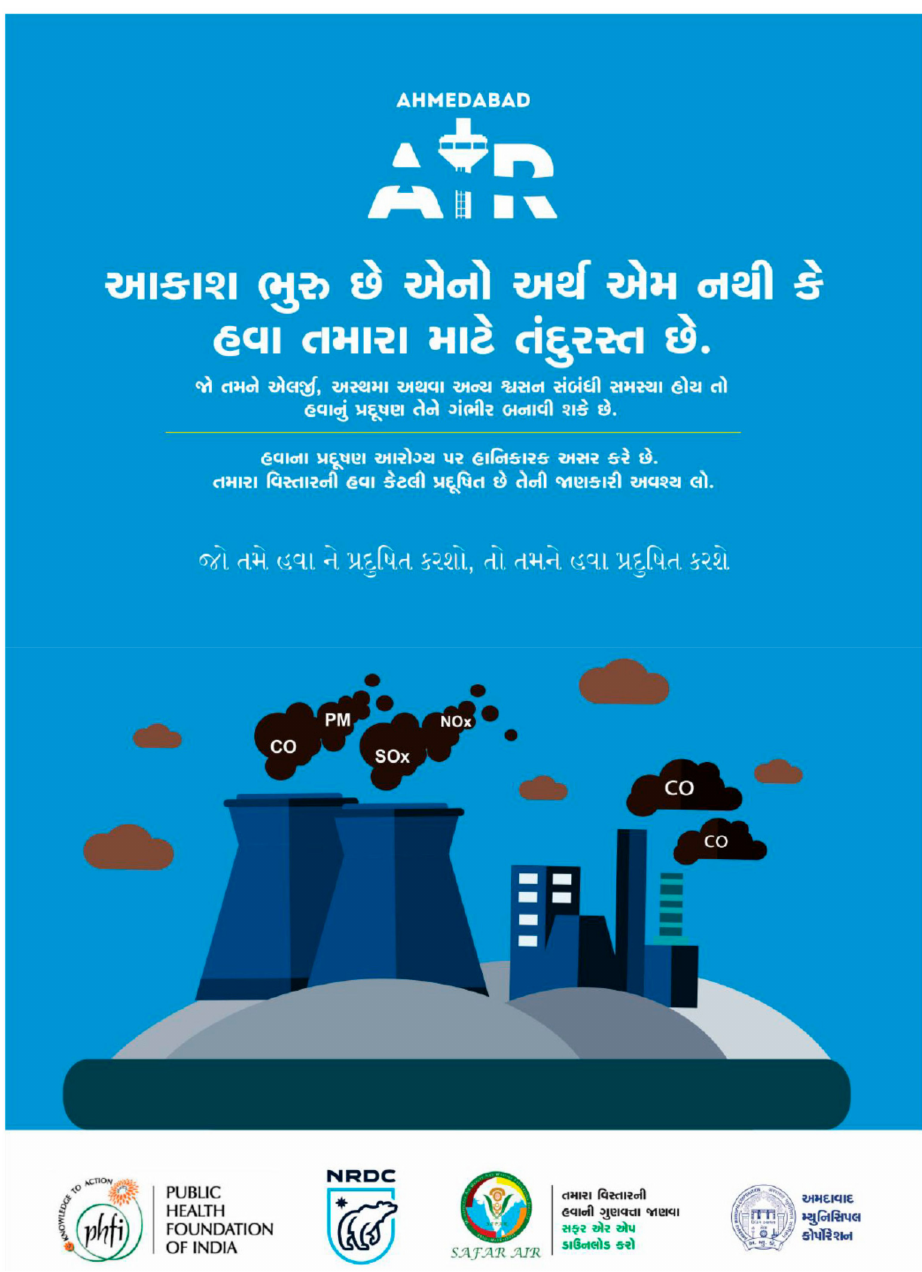
Figure 4. Example AIR Plan IEC outreach materials delivered in Gujarati to enhance public awareness on major air pollution sources, including thermal coal-fired power